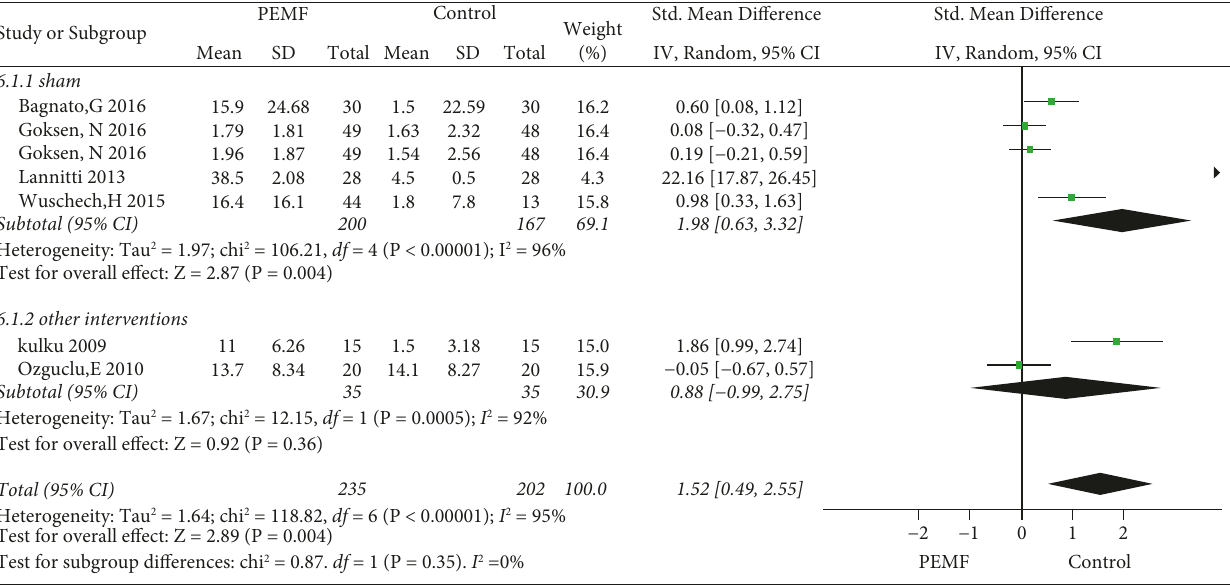
Figure 10: Forest plots represent the effect of PEMF versus control therapies in physical function and subgroup analysis basing on different type of control